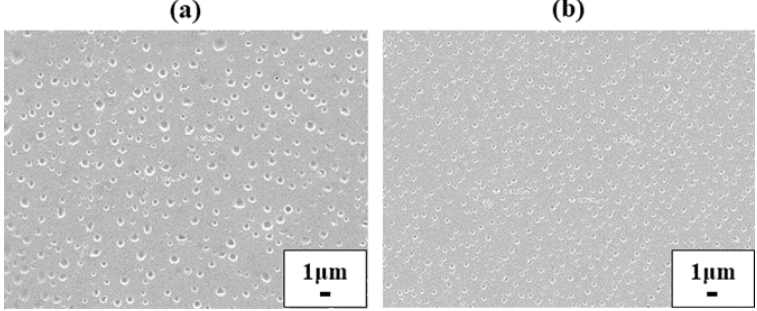
Figure 8. Low-magnification ( × 3000) SEM images of CPI membrane films with. ( a ) 6FAm and ( b ) 6FAm-OH containing 5.0 wt% PVA.